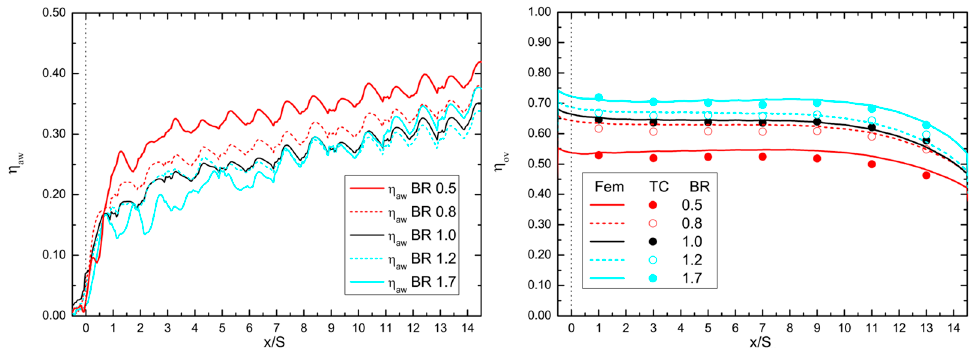
Figure 7. Effects of BR on the lateral-averaged adiabatic effusion cooling efficiency and the lateral- averaged overall effusion cooling efficiency. Reprinted with permission from [75]. Copyright 2010 ASME.